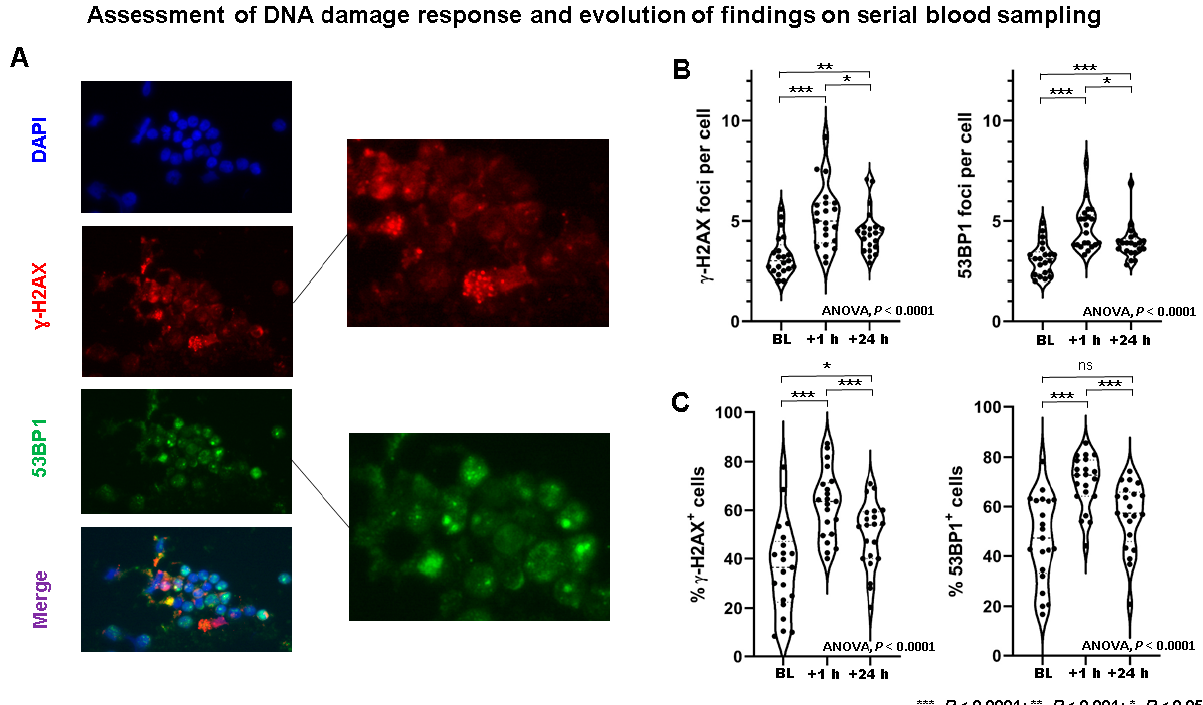
Figure 2. Assessment of DNA damage response in patients receiving peptide receptor radionuclide therapy (PRRT). ( A